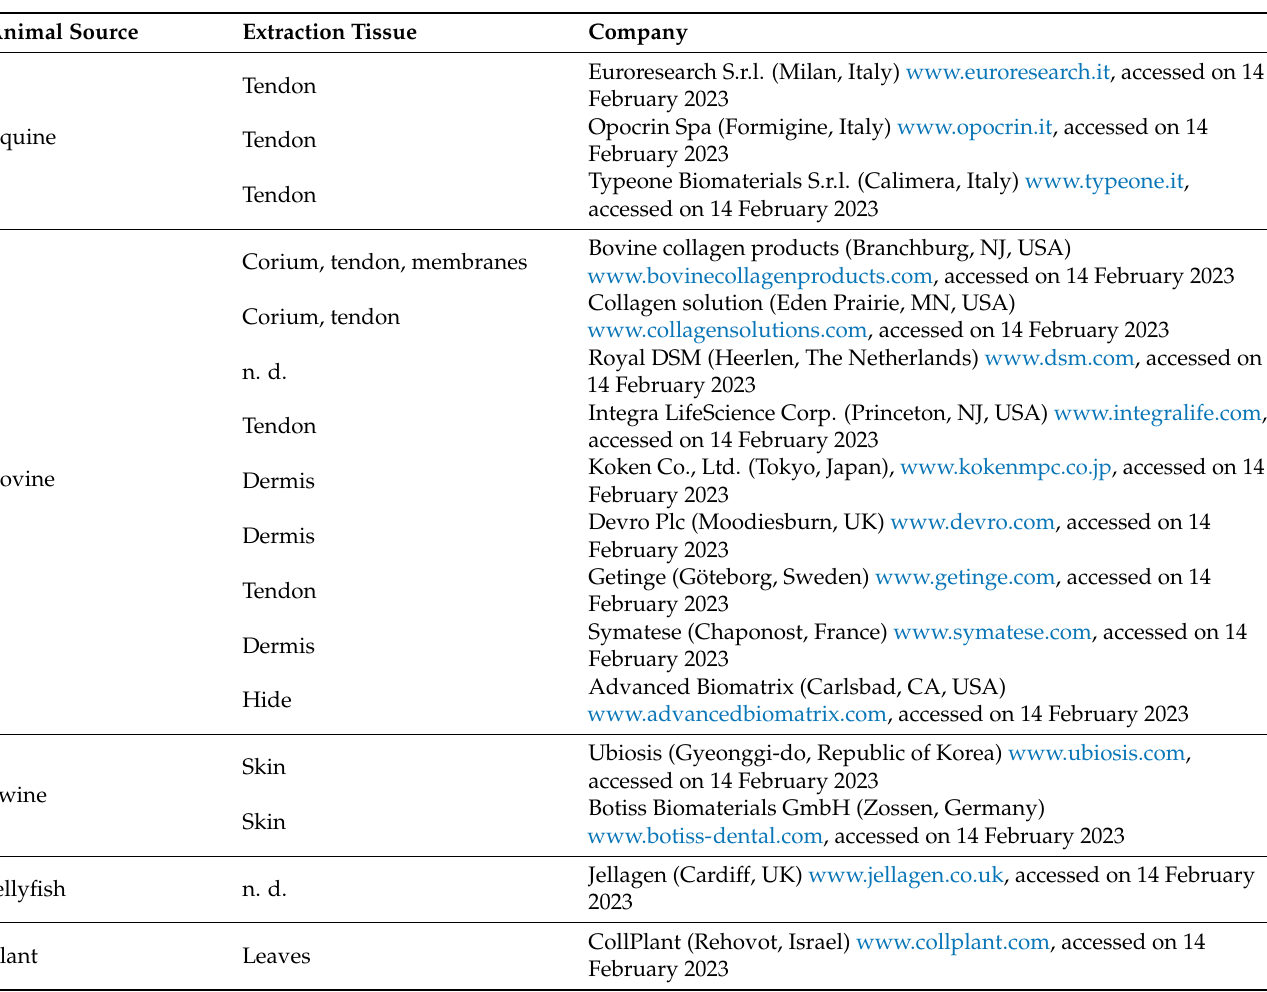
Table 1. Most important world companies producing clinical grade collagen and related extraction